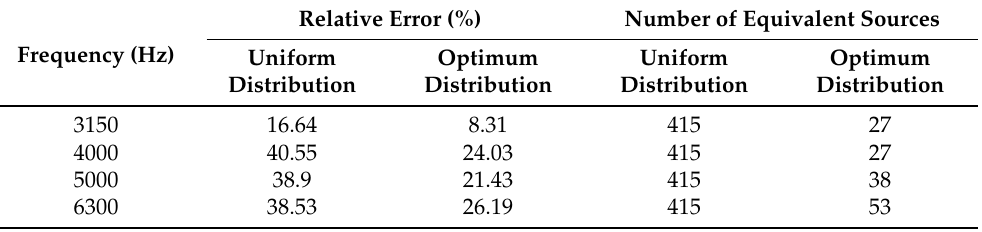
Figure 16. A comparison of the measured values and the computed SPL. Frequencies: ( a ) 3150 Hz, ( b ) 4000 Hz, ( c ) 5000 Hz, and ( d ) 6300 Hz. Table 2. The relative errors and the numbers of equivalent sources for sound field